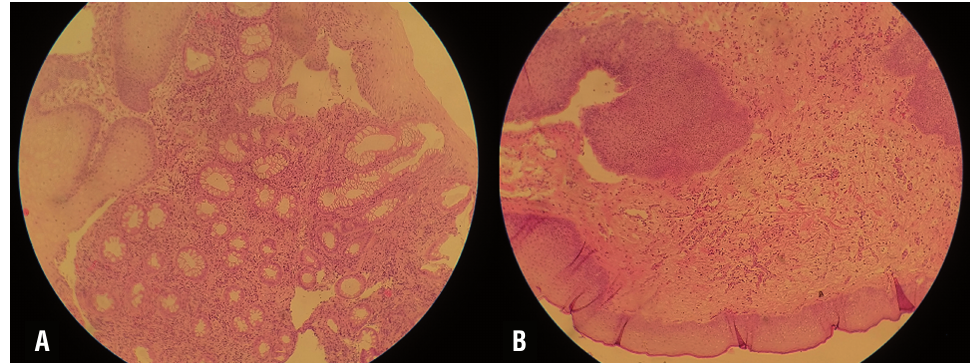
figure 4 - Histological evaluation of the biopsies taken from patients with LDpE (A) and pvdc (B) wrap with no malignancy or pathological changes